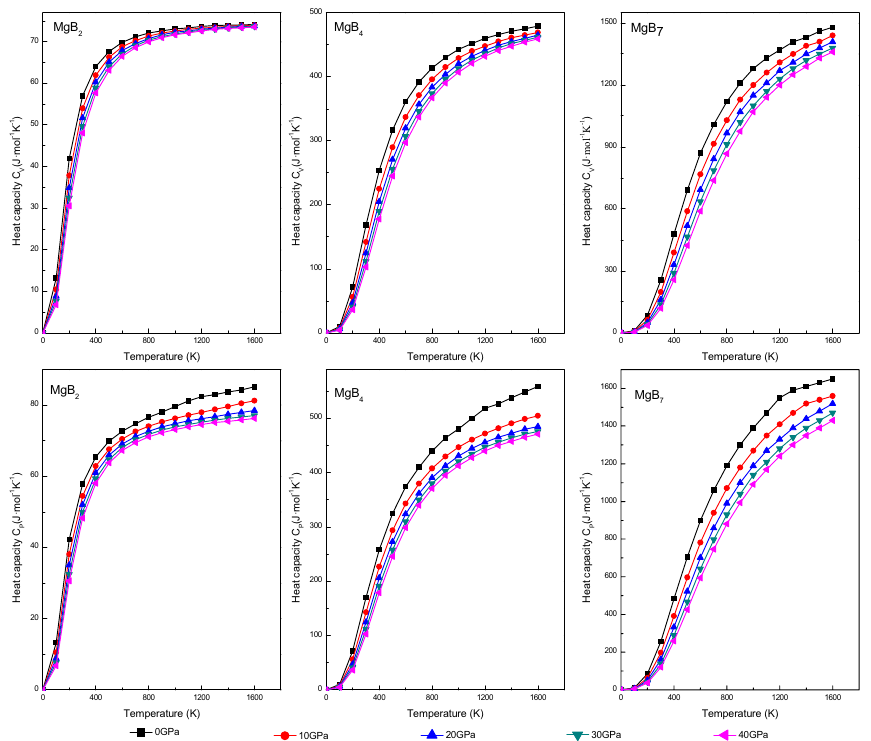
Figure 11. Pressure and temperature dependence of heat capacity C V , C P of Mg–B